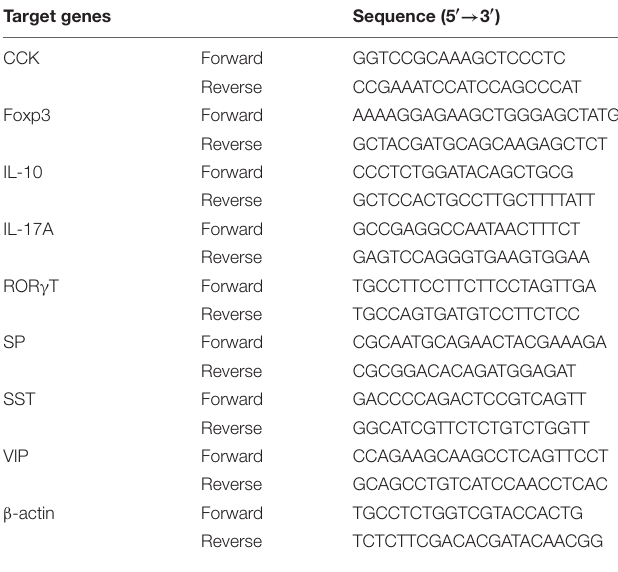
TABLE 1 | Primers used in quantitative real-time PCR. Target